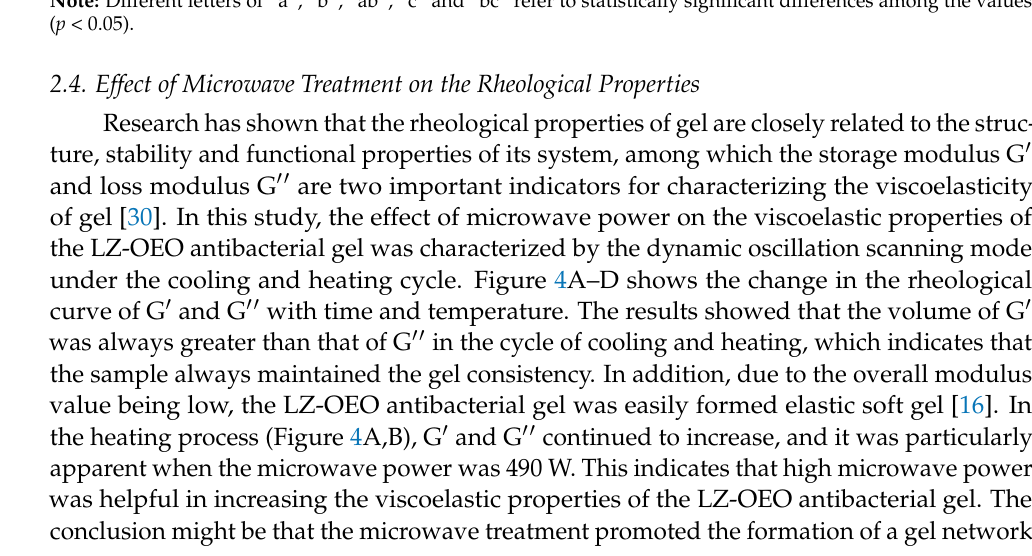
Table 1 . The effect of microwave power on the lateral relaxation time and related peak area of lyso- zyme-oregano essential oil (LZ-OEO) bacteriostatic gels.